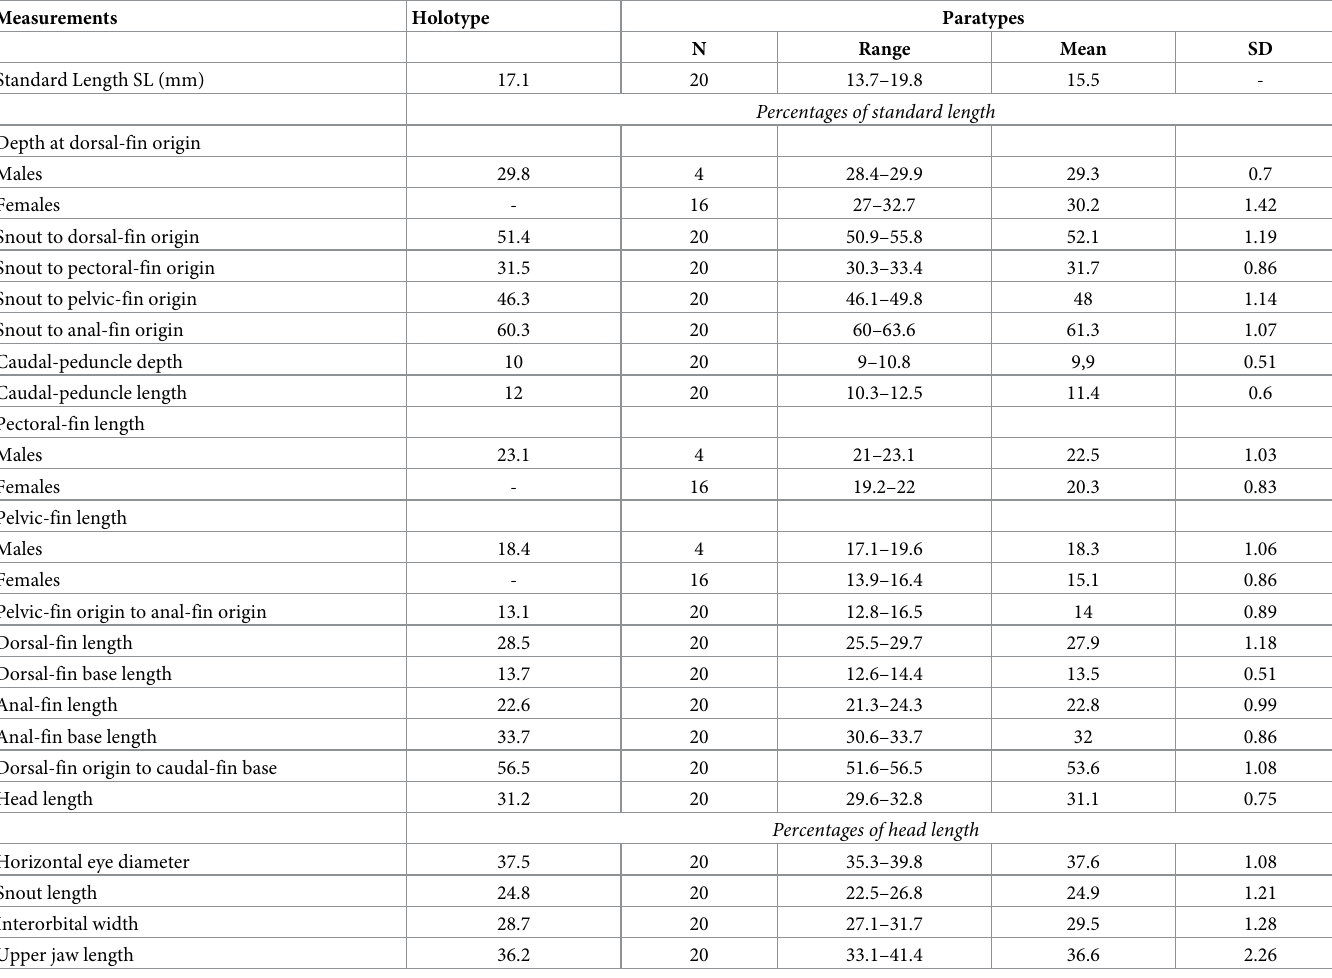
Table 1. Morphometrics of Tyttobrycon shibattai from MZUSP 125268 and MZUSP 125269. N = number of specimens, SD = Standard